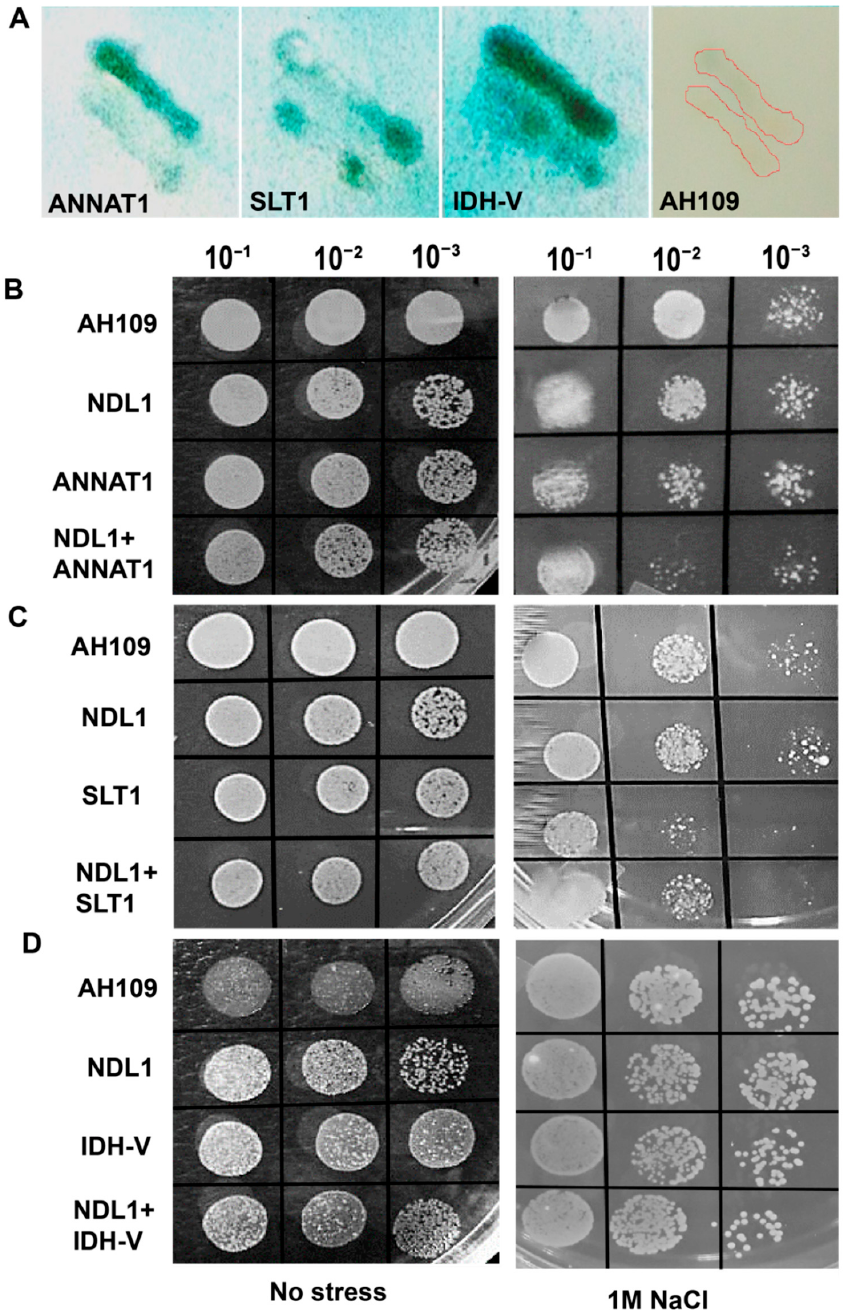
Figure 4. Analysis of salt specific interactome of NDL1 using Yeast. ( A ) Qualitative β -gal comple- mentation assay to confirm in-vivo interaction of NDL1 with their putative interactors using Colony Filter Lift Assay. β -gal complementation assay showing in-vivo interaction between NDL1 and select SRPIN candidates (ANNAT1, SLT1 and IDH-V). Images of filter lifts were taken after overnight incubation. No color was obtained for control having only single construct ( NDL1 alone). ( B ) Yeast cells growth was analyzed on 1 M NaCl, when both NDL1 and ANNAT1 , ( C ) NDL1 and SLT1 and, ( D ) NDL1 and IDH-V were co-transformed together, cell growth in terms of number of the colonies formed was analyzed. Results shown are representative of yeast growth assay performed five times. Exponentially grown yeast cells were harvested and adjusted at OD600 = 1.0. Then, ten- μ Lof serially diluted culture were spotted on YPD plates with and without 1 M NaCl. Plates were incubated at 30 °C and growth was analyzed after 2 days.